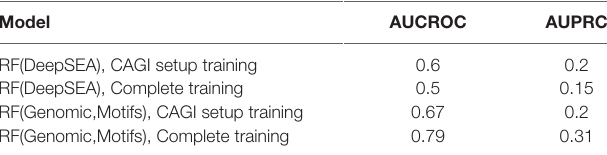
TABLe 1 | Area under precision-recall curve (AUPRC) and area under curve for receiver operating characteristic (AUCROC) reached by the baseline models on the independent validation